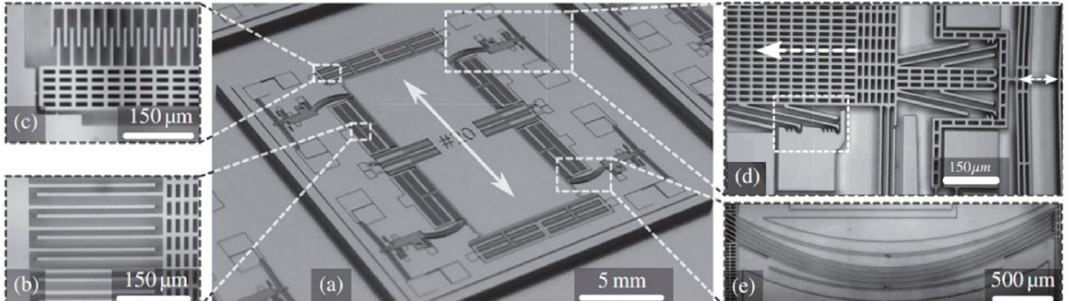
Figure 3. SEM images of MEMS accelerometer developed by Boom and Kamp et al . at Nikhef and University of Twente [13,16]: ( a ) entire sensor chip, ( b ) sense comb fingers, ( c ) actuation electrodes, ( d ) preloading mechanisms, ( e ) one of the suspension spring sets in a compressed state.